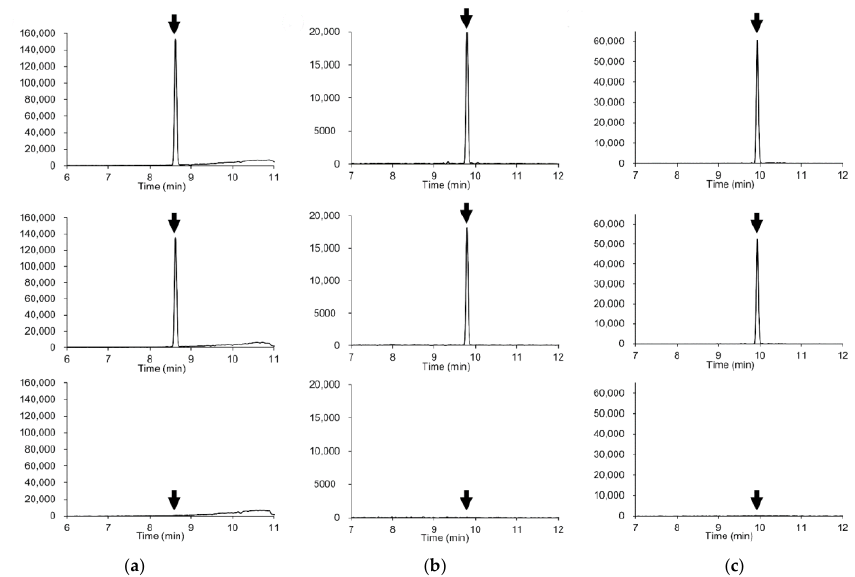
Figure 1. Extracted ion chromatograms (mass window ±5 mDa) of representative compounds. ( a ) Azoxystrobin ( m/z 404.1241); ( b ) Diazinon ( m/z 305.1083), ( c ) Indoxacarb ( m/z 528.0780). Upper plots: standard solution in solvent (0.005 μg/mL, corresponding to 0.01 mg/kg). Middle plots: soybeans spiked with 0.01 mg/kg of the pesticide. Lower plots: soy- bean blank extract.